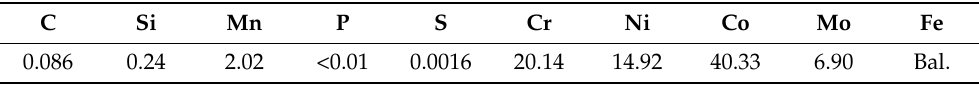
Table 1. Chemical composition (wt.%) of Co40NiCrMo